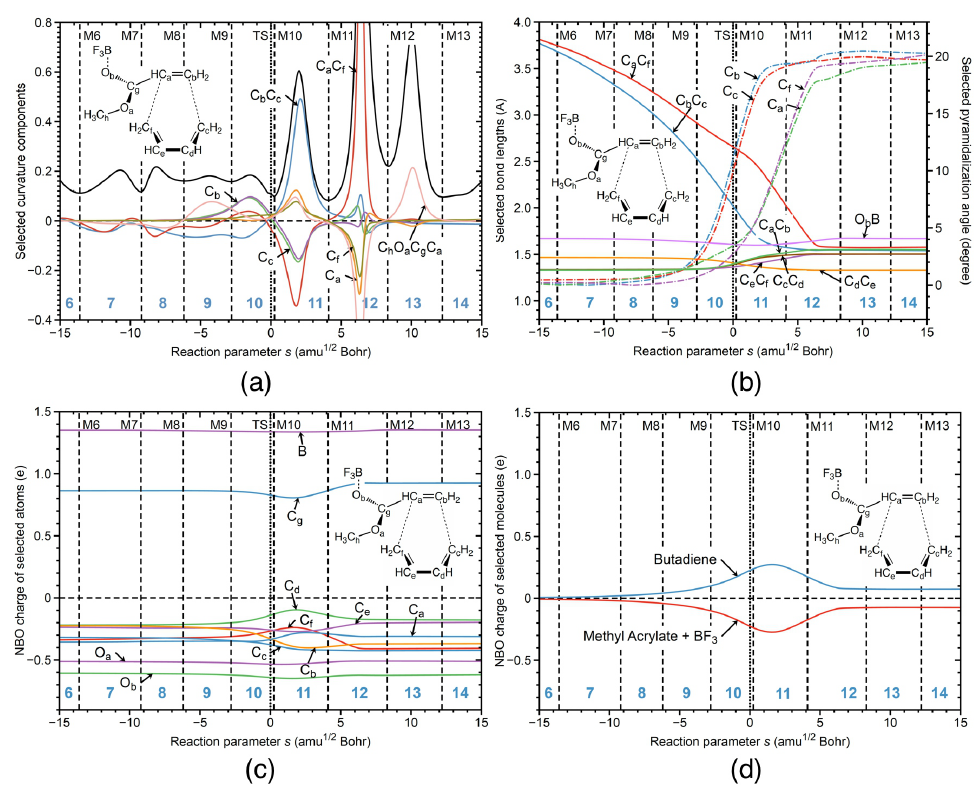
Figure 6. R1cg reaction properties along the reaction path; ( a ) decomposition of the reaction curvature into selected components; ( b ) change of the selected geometrical parameters; ( c ) change of the NBO charges of selected atoms; ( d ) change of the NBO charges of selected molecules. B3LYP/6-311+G(2d,p) level of